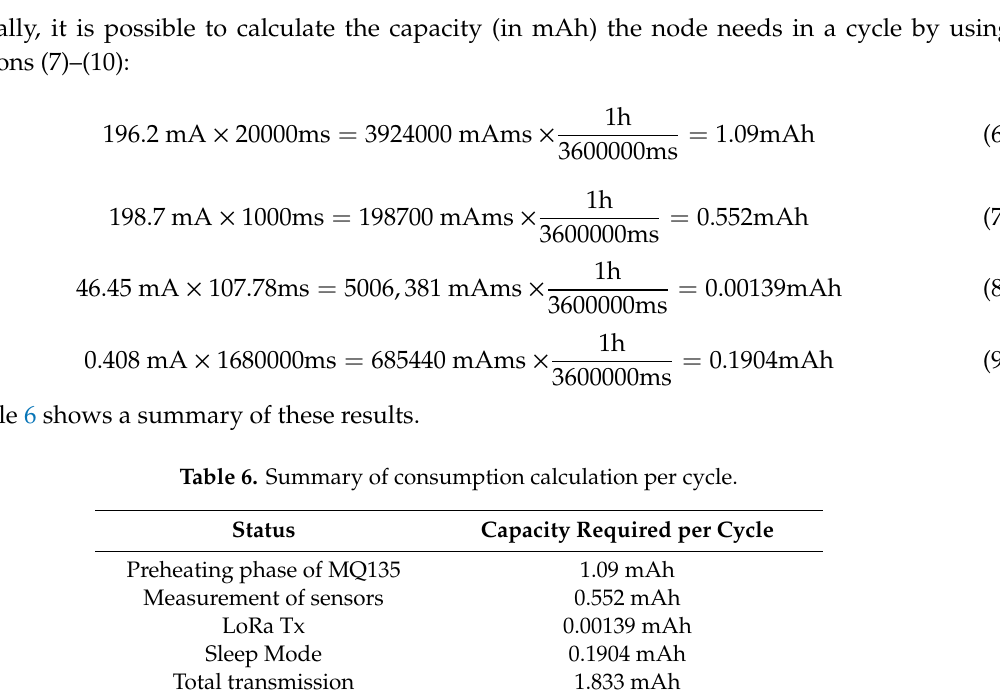
Figure 25. Diagram operating time of the device in each state.